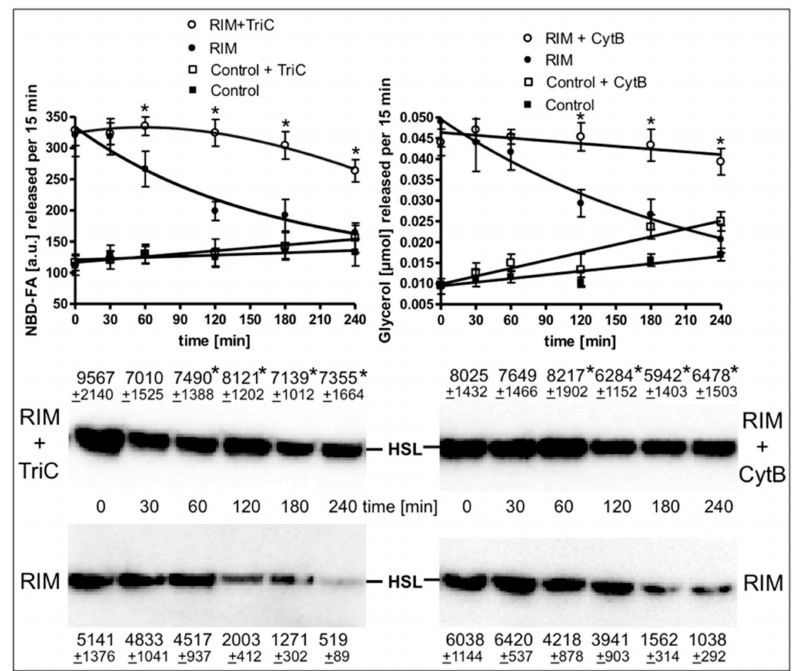
Figure 7. Loss of the Rimonabant-induced lipolysis and HSL translocation in adipocytes by ongoing lipid synthesis. Primary rat adipocytes, which had been metabolically labelled with -((7-nitrobenz-2-oxa-1,3-diazol-4-yl)amino)dodecanoic acid (NBD-FA), were pretreated (20 min, 37 ◦ C) in the absence (Control) or presence of 10 µ M Rimonabant (RIM). Thereafter, 500- µ L aliquots of the incubation mixtures were transferred into 2-mL Eppendorf vials and then subjected to centrifugation (500x g, 2 min). Subsequently, the infranatant was removed by suction and the adipocytes were suspended in 2 mL of fresh incubation medium lacking Rimonabant. After two additional flotation cycles, the washed adipocytes were incubated (37 ◦ C) in medium harboring 10 mM glucose and 0.1 nM insulin in the absence or presence of cytochalasin B (10 µ M; CytB) or triacsin C (30 µ M; TriC) for the periods indicated. Subsequently, the adipocytes were washed by flotation, resuspended and then incubated (15 min, 37 ◦ C). Upper panel: The amounts of NBD-FA and glycerol released into the incubation medium were measured by fluorometry and enzymatically, respectively. Mean ± SD of two di ff erent adipocyte preparations with incubations / measurements in triplicate. Middle and lower panels: The amounts of HSL associated with LD, which were prepared from the homogenates of the adipocytes by centrifugation through sucrose cushions, were determined. For this, proteins contained in the top fraction were extracted from the lipids, then separated by SDS-PAGE and analyzed for HSL by immunoblotting. The images of a typical experiment with LD preparations and electrophoretic runs in triplicate with quantitative evaluations (mean ± SD) are shown. * p ≤ 0.05 for Rimonabant-treated adipocytes between absence and presence of TriC or CytB; no significant di ff erences for control